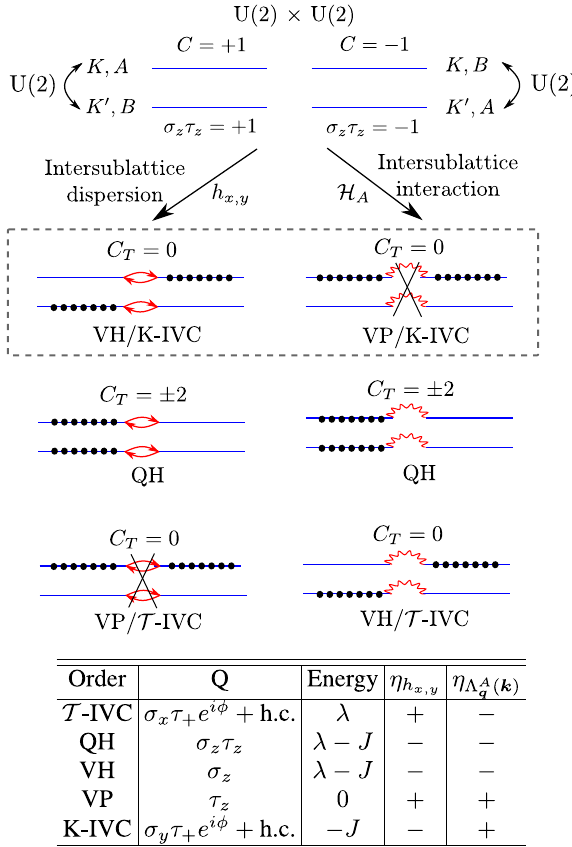
FIG. 6. Schematic illustration of the symmetry reduction and ground-state selection in the spinless model (top panel). Begin- ning with the U ð 2 Þ × U ð 2 Þ symmetric intrasublattice interaction H , which allows for free rotations within the two C ¼ 1 and two S C ¼ − 1 levels, the symmetry is lowered by the dispersion h x;y (left) and the intersublattice interaction H (right), which splits A the degenerate states. The K-IVC insulator is the unique state that is optimal for both perturbations. Table of the low-energy states in the spinless model, showing how their energy is affected by ∝ σ τ dispersion h , σ and finite sublattice polarization x;y x y z k Þ ∝ σ τ Λ A ; σ =U (bottom panel). Here, J ∼ t 2 and λ ∼ q ð x z y S S =U = − depending U 2 are of the order 1 – 2 meV, and η S x ¼ þ A on whether the commutator/anticommutator of Q and x vanishes, i.e., ½ Q; x (cid:3) η ¼ 0 x